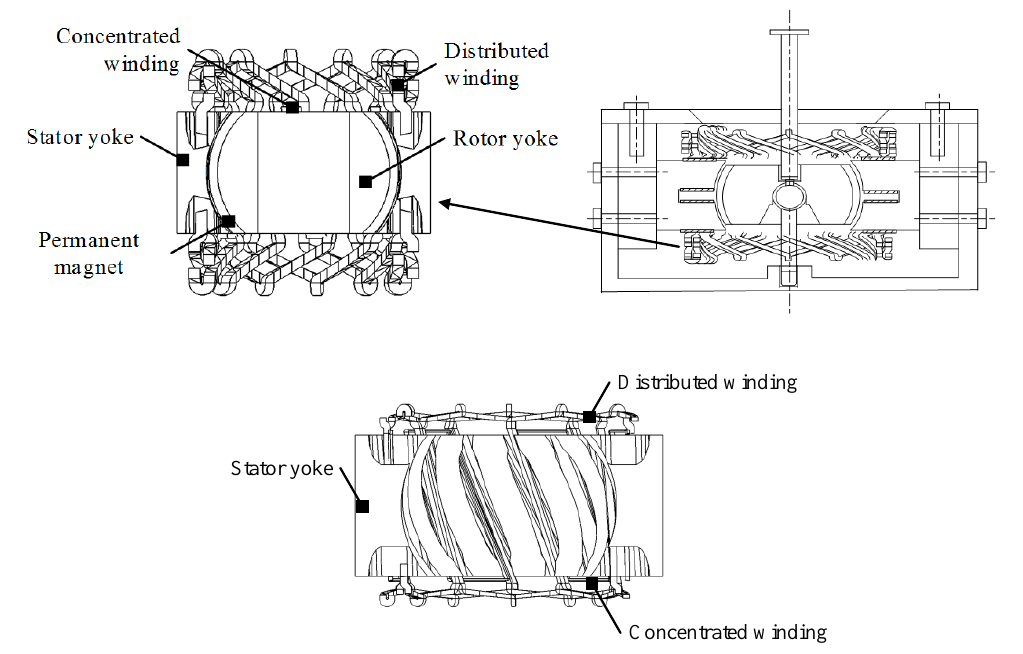
Figure 1. Basic structure of the generator.